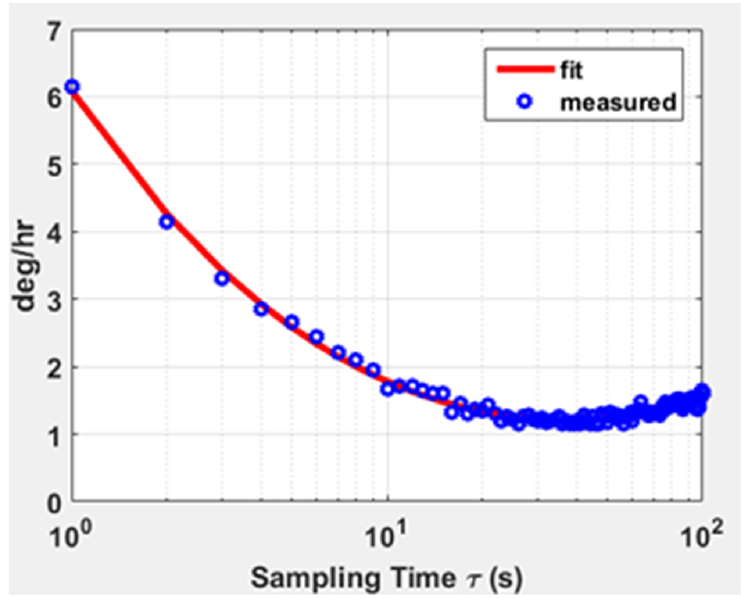
Figure 15. Zero output fitting curve for gyroscope generated using Allen variance.